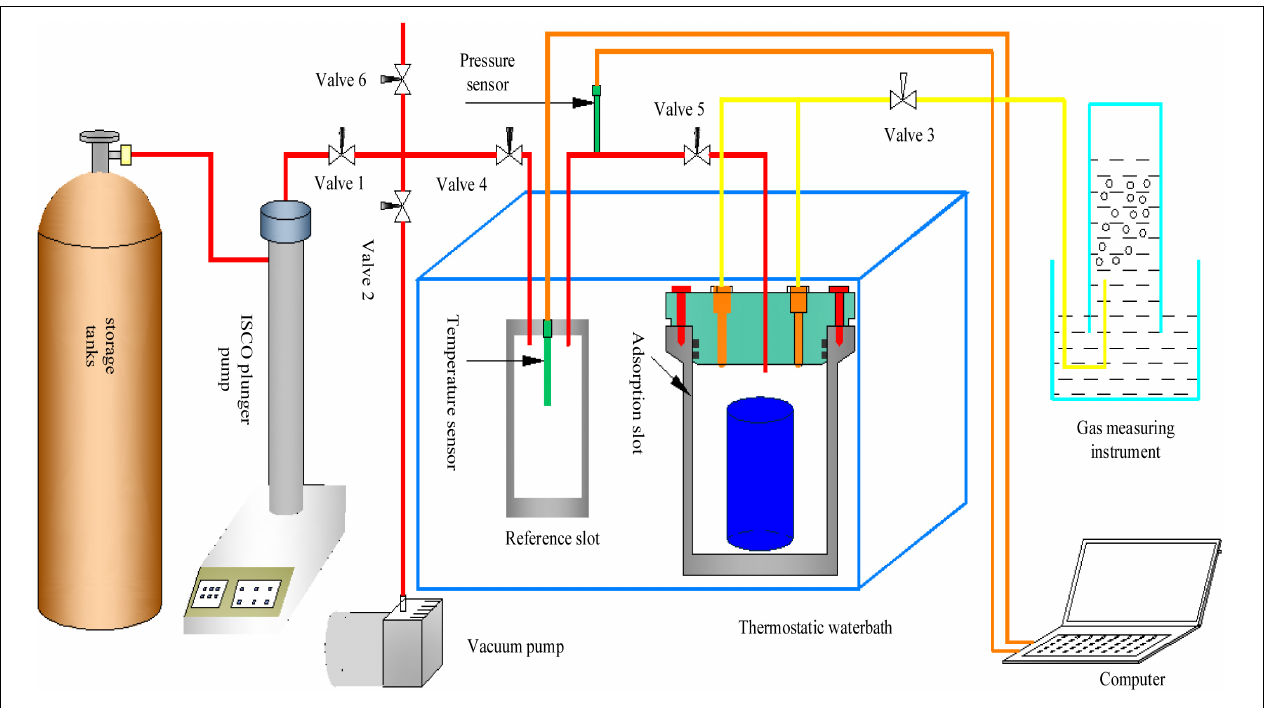
FIGURE 4 | Desorption-adsorption simulating testing device.